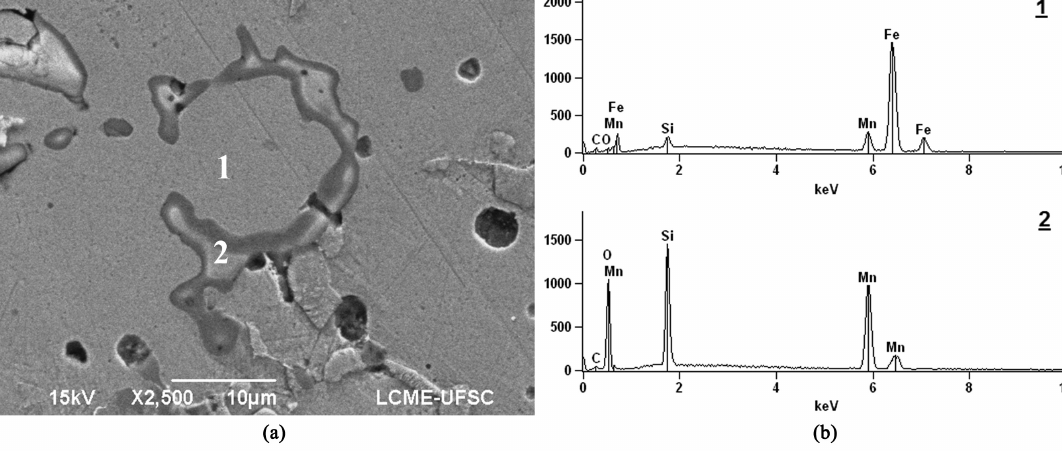
Figure 6. SEM analysis showing oxidation in atmospheres containing higher amounts of oxygen. (a) SE image. (b) EDS analyses of points 1 and 2. Author: Renan